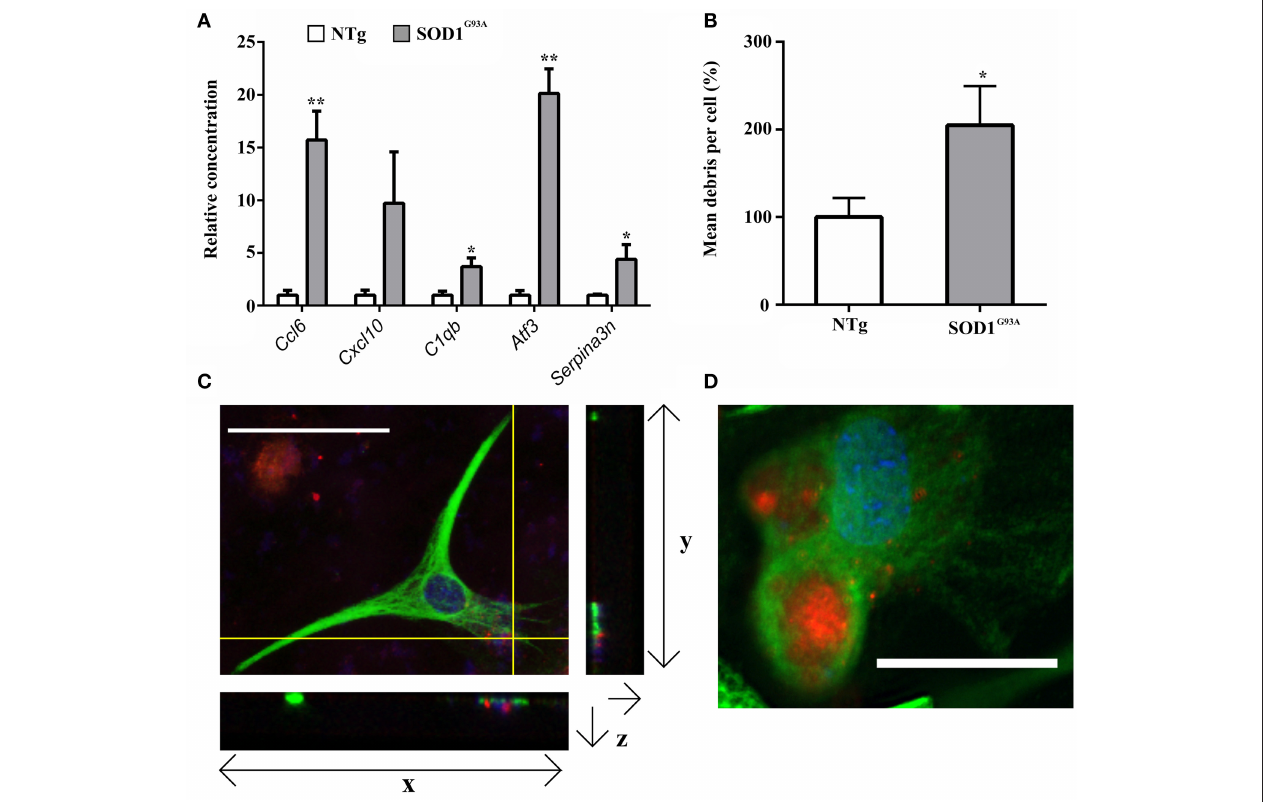
FIGURE 2 | (A) qPCR upon symptomatic RNA of five transcripts differentially expressed in symptomatic and late-stage SOD1 G93A astrocyte microarray data and putatively involved in their immuno-reactive phenotype, including the chemokines Ccl6 and Cxcl10 , the complement component C1qb , the stress response transcription factor Atf3 and the serpin peptidase inhibitor Serpina3n ; n = 3 per group. (B) SOD1 G93A astrocytes phagocytose a significantly greater area of debris vs. NTg control. Results expressed as a percentage of control (NTg = 100% ± S.E.M. 12.62, SOD1 G93A = 204.84 % ± S.E.M = 25.88). n = 3 . (C) Confocal microscopy reveals NSC34 debris (red) to be in the same plane as GFAP staining (green). Crosshairs indicate location of zy and zx view. Note colocalisation of debris and GFAP in zx field. Both nuclei of astrocytes and nuclear debris of NSC34 cells are observed stained blue. (D) InCell image of GFAP + astrocytes (green) phagocytosing NSC34 cell debris (red), nuclei are stained in blue. * p ≤ 0.05 , ** p ≤ 0.01 . Error bars = S.E.M. Scale bars = 25 µ